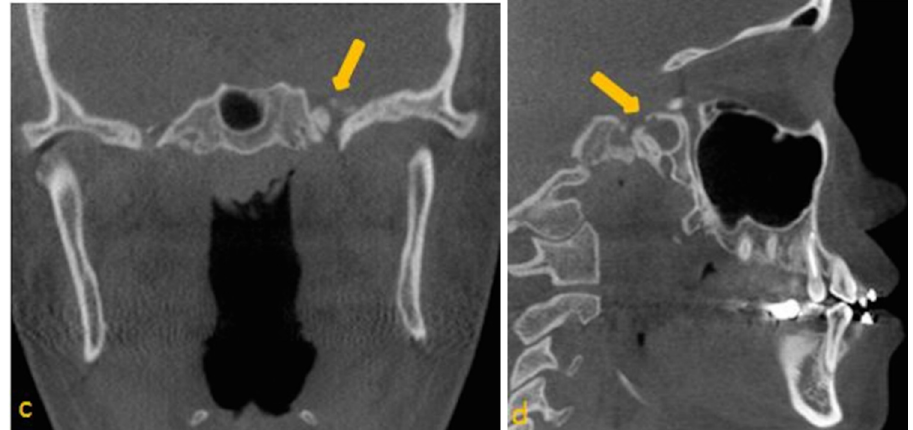
Figure 1. ( a ) Para-axial; ( b,c ) Paracoronal and ( d ) Parasagittal CBCT images